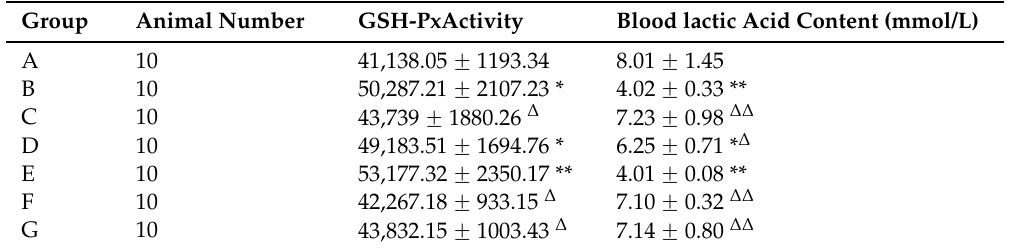
Table 9. Fe-HPH II chelate and the glutathione peroxidase (GSH-Px) activity and blood lactic